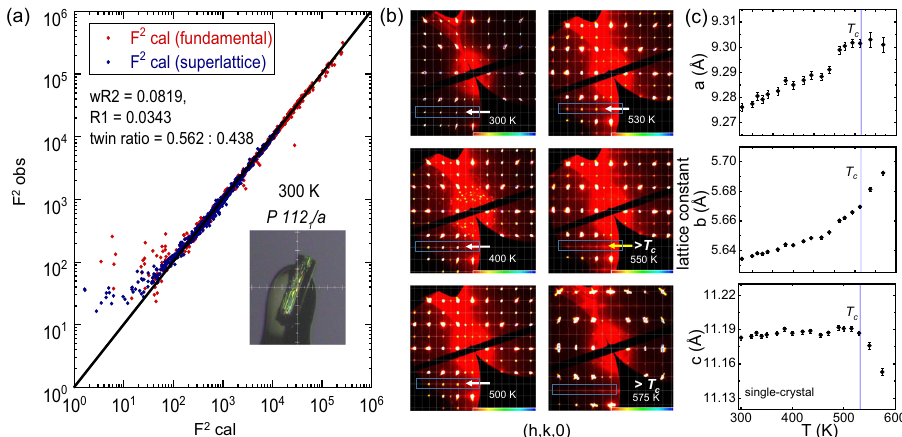
Fig. 2 Room-temperature SC-XRD re fi nement for LT-phase: Single-crystal XRD reciprocal-lattice images and lattice parameters across the structural transition. a The SC-XRD re fi nement includes a modi fi ed structural model with a new space group ( P112 1 / a ) determined from CBED experiments. The re fi nement is performed by including a monoclinic merohedral twin model under twin law as (-100) (010) (00-1). The solid red and blue circles are fundamental and superlattice re fl ections, respectively. The inset of the fi gure shows the optical image of the measured crystal. b Single-crystal x-ray diffraction data measured at various temperatures below and above the phase transition ( T c = 535 K) for NaRu 2 O 4 . c The cell parameters with error bars of NaRu 2 O 4 at different temperatures extracted from single-crystal XRD data. The vertical line corresponds to T c